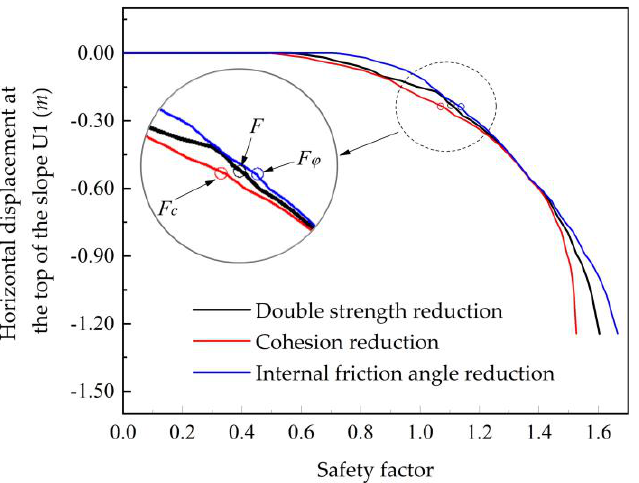
Figure 15. Variation of horizontal displacement at node B on the slope’s top .